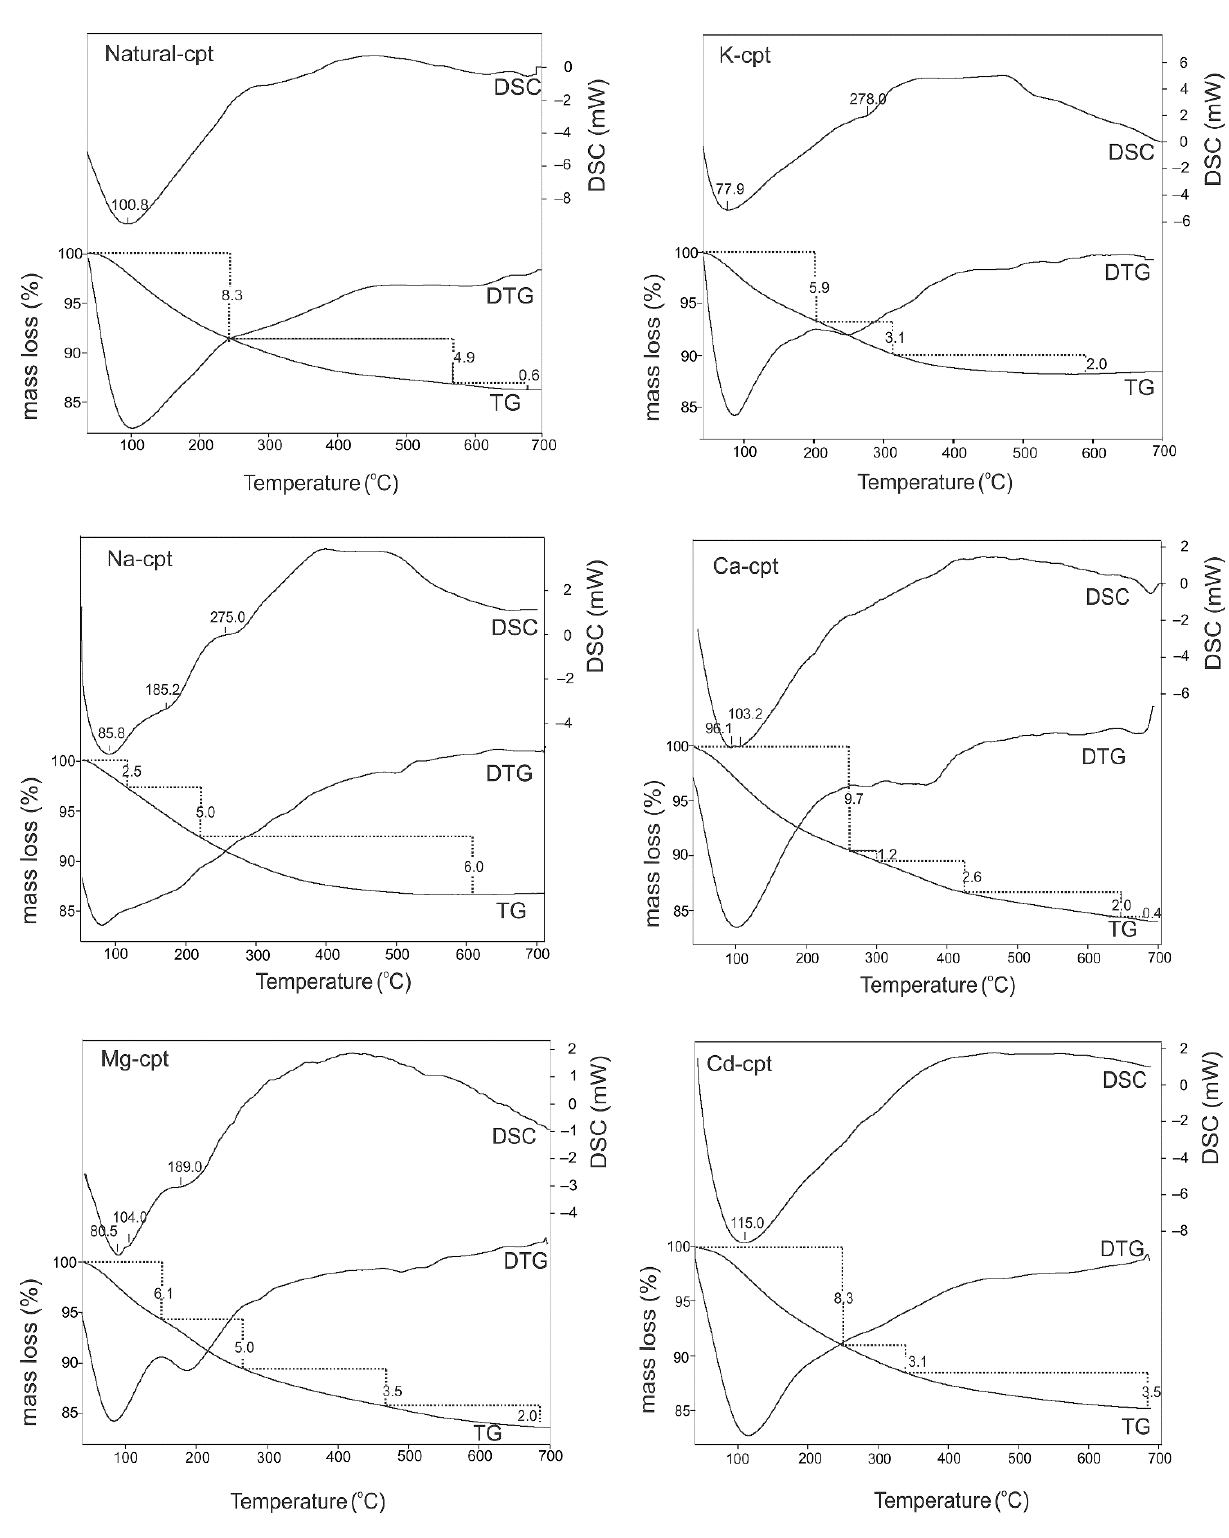
Figure 2. DSC-TG(DTG) curves of natural and exchanged forms of clinoptilolite.